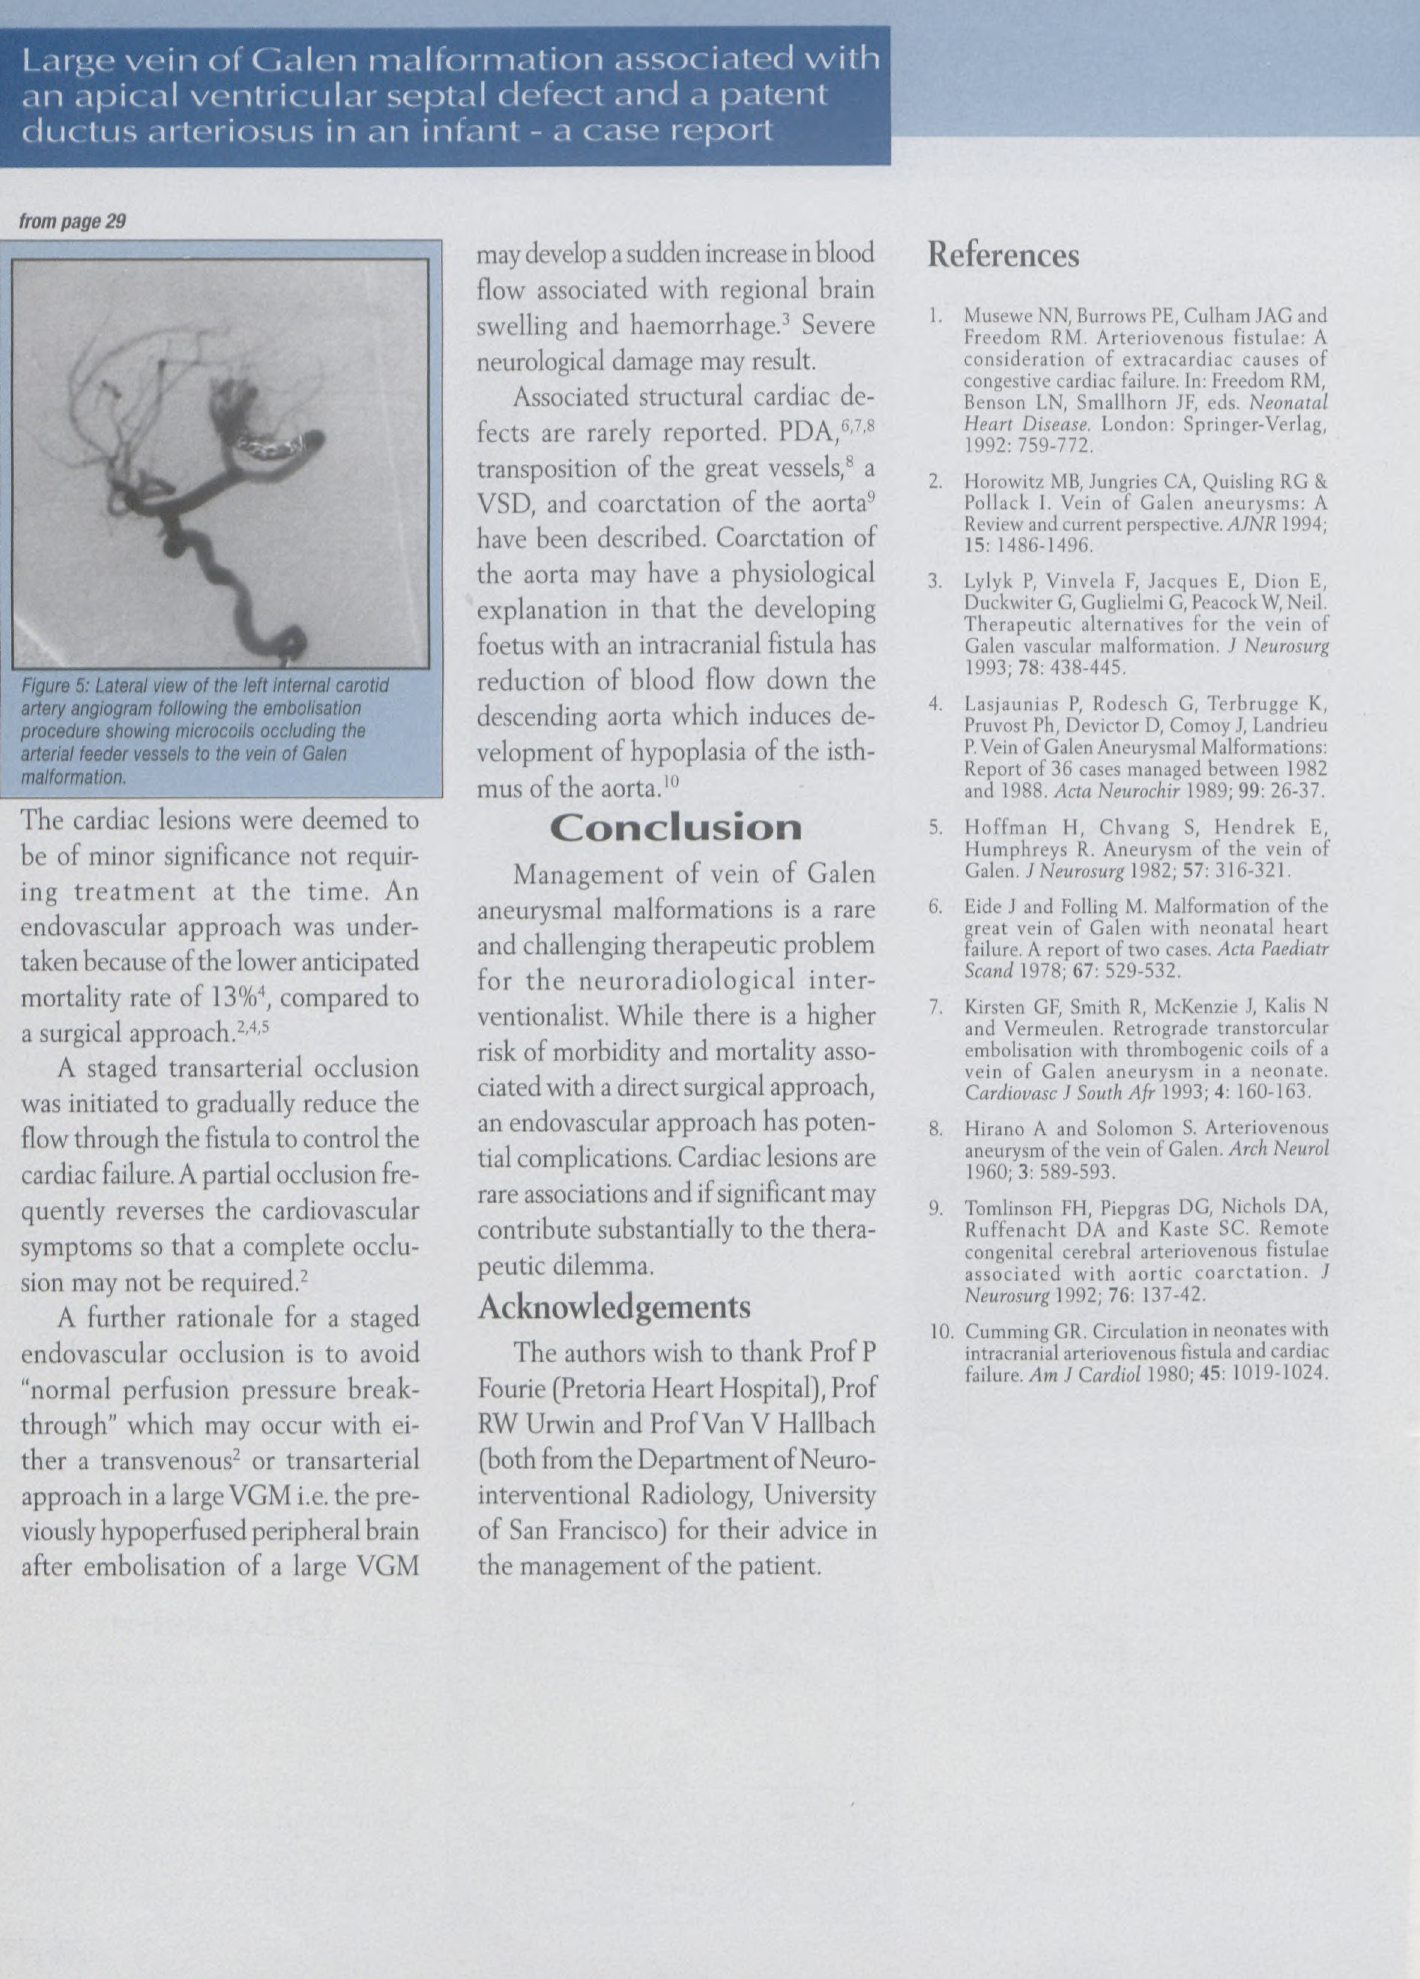
Figure 5: Lsteral view of the left internal carotid artery angiogram following the embolisstion procedure showing microcails occluding the arterial feeder vessels to the vein of Galen